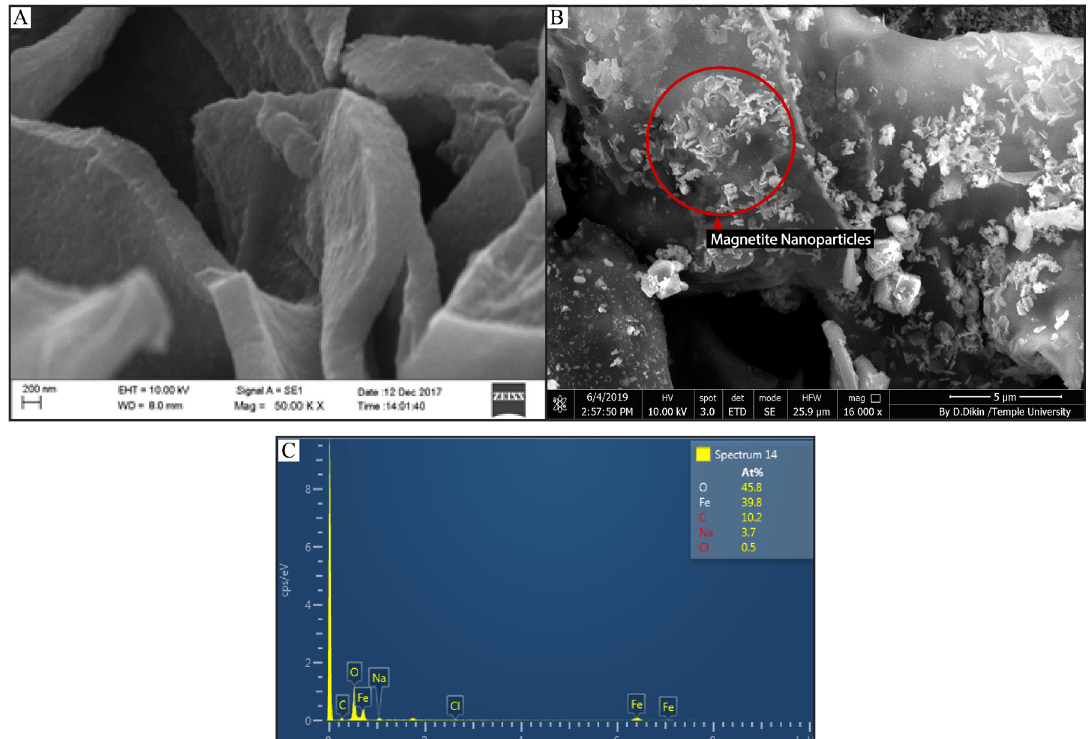
Figure 2: SEM images of activated and pyrolyzed coconut coir (PCC) are compared with magnetite impregnated pyrolyzed coconut coir (M-PCC). (A) PCC under 50,000 × magnification; (B) M-PCC image under 16,000 × magnification; (C) EDX spectrum of M-PCC.